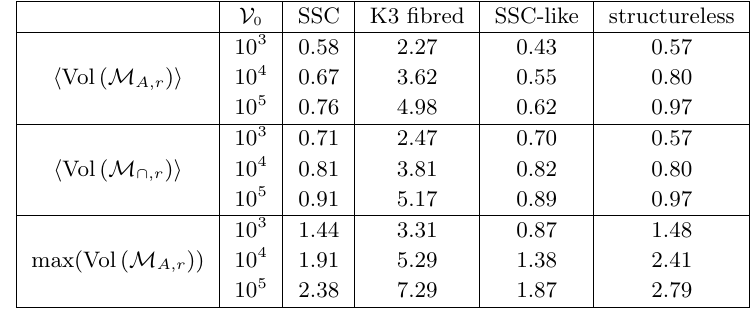
Table 3 . Average volume in units of M p of the two di(cid:11)erent approximations M A;r and M \ ;r of the reduced moduli space of LVS vacua with h 1 ; 1 = 3. We also show the maximal value of the size of the reduced moduli space M A;r obtained from the ambient Mori cone M A .